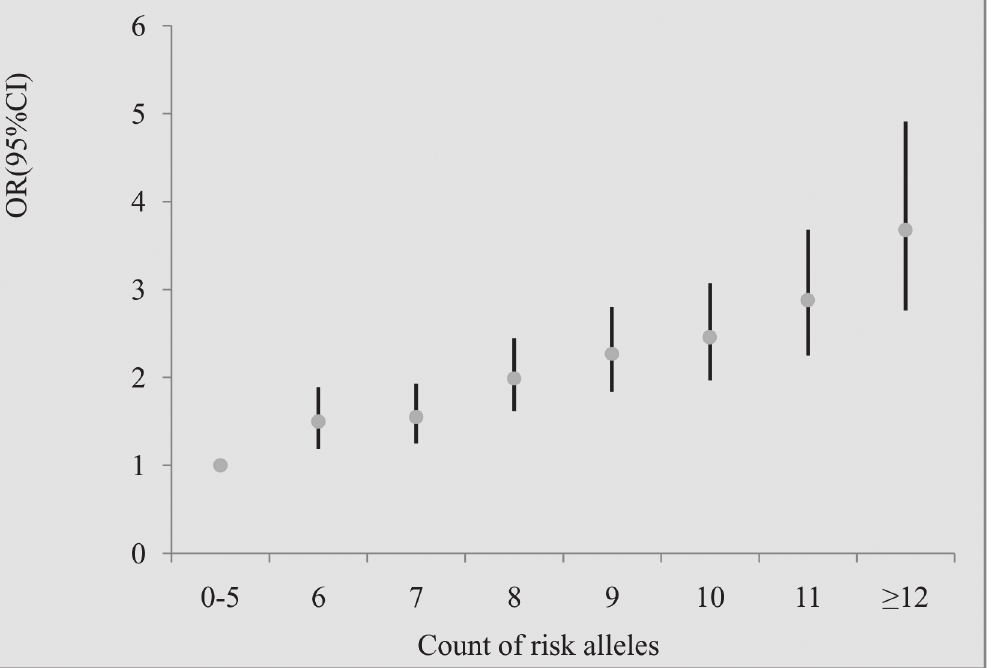
Figure 2. Odds ratios for risk of type 2 diabetes according to the number of risk alleles carried. As the small sample size, those carrying 0 – 5 risk alleles were grouped together and those carrying (cid:1) 12 risk alleles were likewise done. The combined effect of 9 single nucleotide polymorphisms was analyzed using logistic regression adjusted for age, gender and body mass index. The risk for type 2 diabetes increased with the increased number of risk alleles ( P trend = 2.0 × 10 − 30